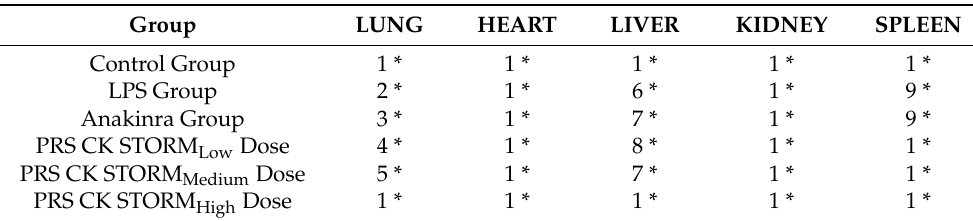
Table 7. Summary of the main events observed in the histological sections of the different organs to be